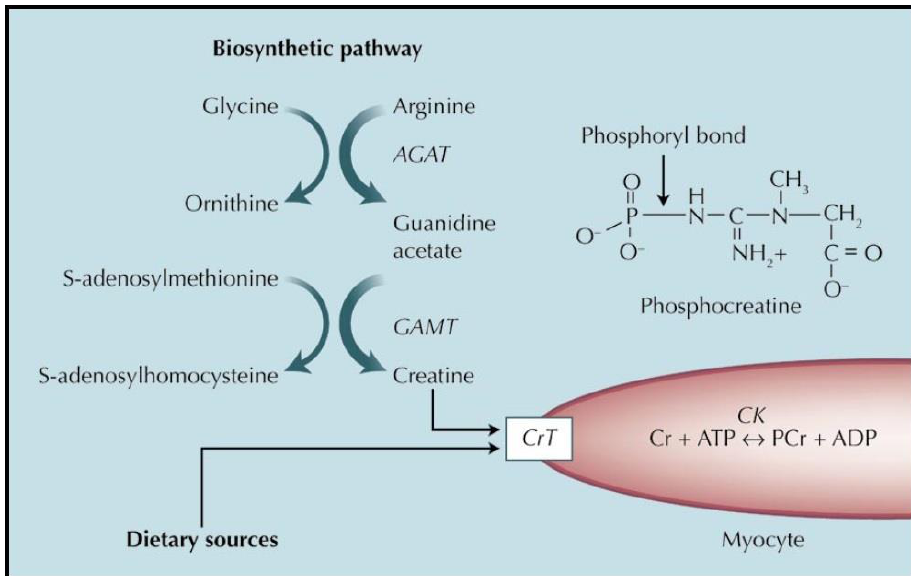
Figure 1. The primary sources for blood-borne creatine (Cr) are diet (meat) and a two-step biosynthesis that occurs primarily in the kidney, liver, and pancreas. Cr, a β-amino acid, is made by the transfer of glycine onto the arginine side chain catalyzed by arginine:glycine amidinotransferase (AGAT) to form guanidinoacetate. The methyl group is transferred to the guanidino group via guanidinoacetate methyltransferase (GAMT). Cr accumulates in muscles and brain through the action of the Cr transporter (CrT) in the sarcolemma. Cr is trapped by phosphorylation to phosphocreatine (PCr, see structure) by creatine kinase (CK). ADP—adenosine diphosphate; ATP—adenosine triphosphate; CrP—creatine phosphate. Reprinted by permission from Springer Nature Customer Service Centre GmbH:Springer Nature, Current Hypertension Reports (On the hypothesis that the failing heart is energy starved: Lessons learned from the metabolism of ATP and creatine, Joanne S. Ingwall) Copyright Springer Nature Customer Service Centre GmbH,